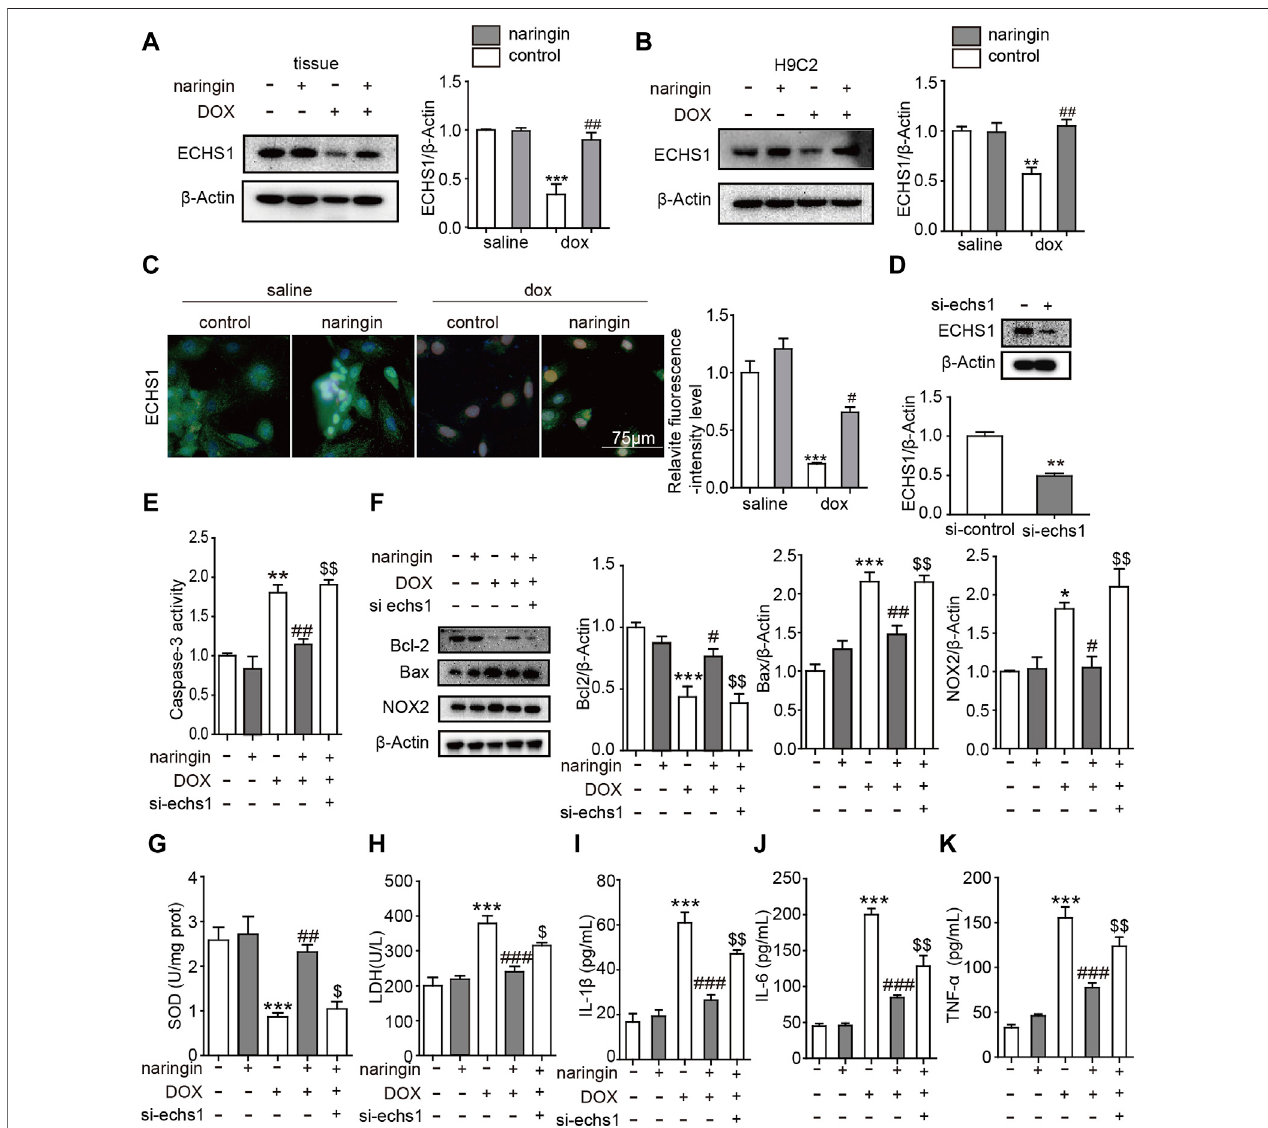
FIGURE5| InhibitionofECHS1interferestheeffectofNaringinonDOX-inducedonapoptosis,in fl ammationandOxidativestress invitro . (A) theproteinexpression levels of ECHS1 in heart tissue (left panel) with quanti fi cation analysis (right panel); (B) the protein expression levels of Bcl-2 in H9C2 cells (left panel) with quanti fi cation analysis (right panel); (C) representative imaging of ECHS1 immuno fl uorescence staining. ECHS1 cells are in green, DAPI in blue.; (D) the protein expression levels of ECHS1 after si-ECHS1 transfection; (E) the activity of caspase3 in different group; (F) the protein expression levels of Bcl-2, BAX, NOX2 and β -actin in heart tissue (left panel) with quanti fi cation analysis (right panel). (G) The content of SOD activity in H9C2. (H) The content of LDH activity in H9C2. (I – K) The level of IL-1 β , IL-6 and TNF- α detected by ELISA. ** p < 0.01, *** p < 0.001 DOX versus control group or si- ECHS1 versus control group; ## p < 0.01, and ### p < 0.001 DOX versus NR + DOX; $$ p < 0.01 NR + DOX versus NR + DOX + si-